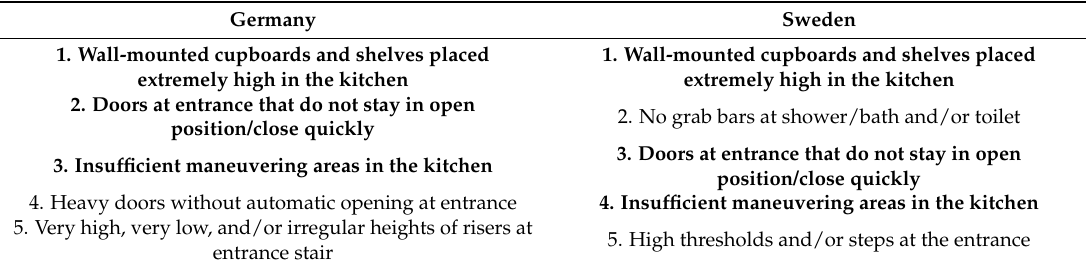
Table 1. Step 1: barriers prioritized based on their relevance for housing